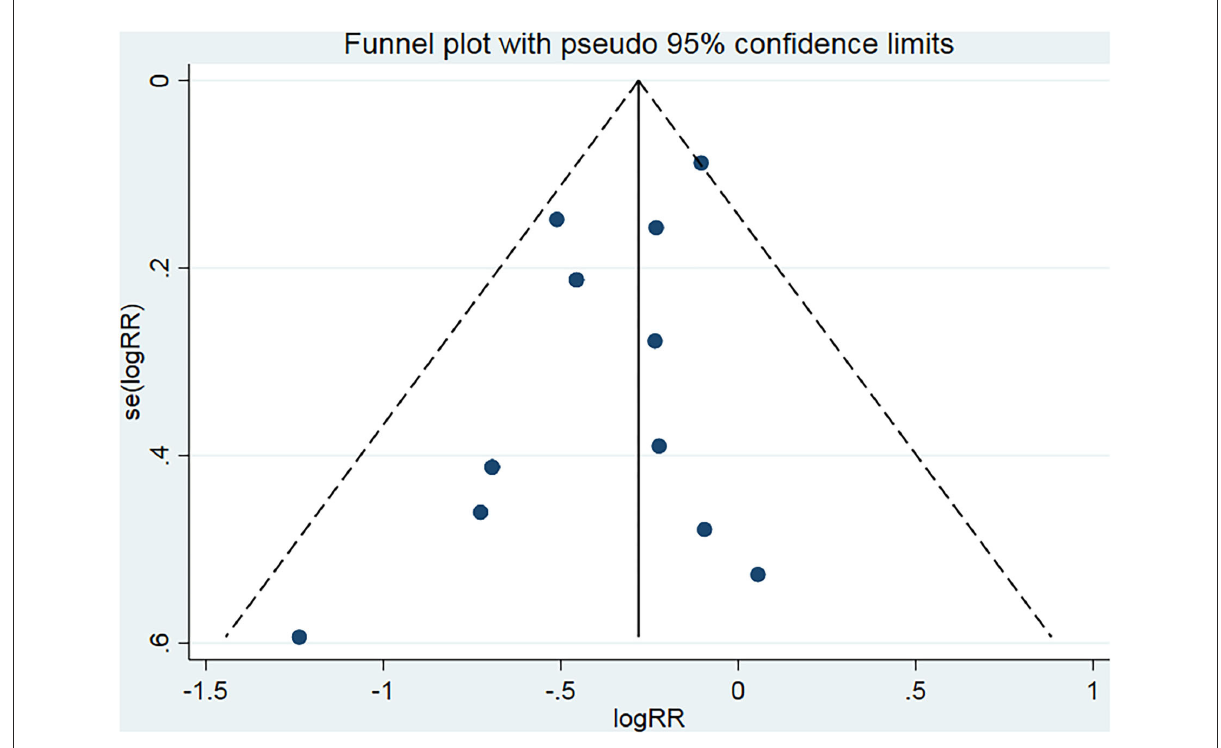
FIGURE5 Funnel plot for the bias assessment. RR, relative risk; SE, standard